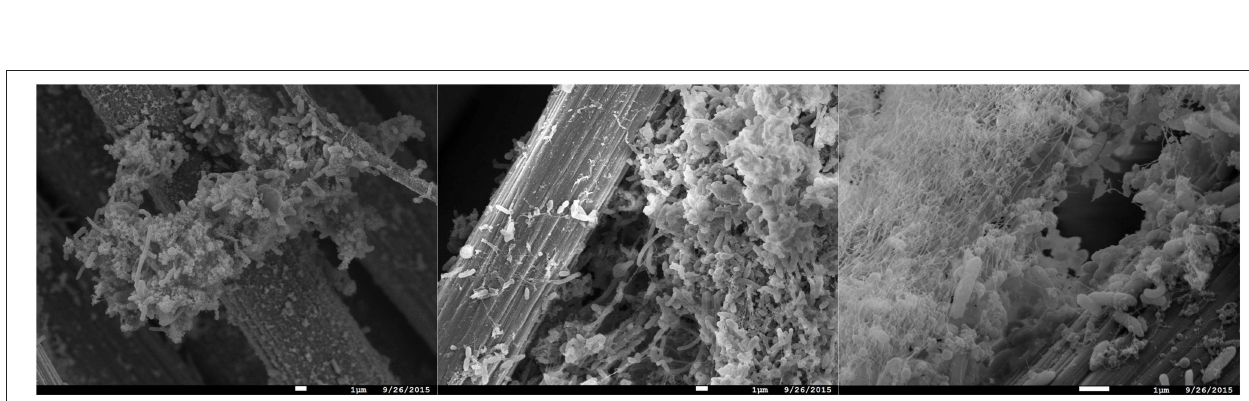
Frontiers in Energy Research |